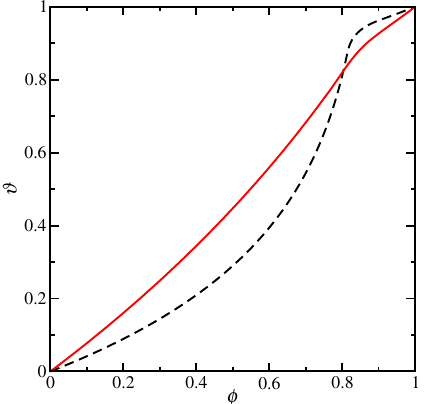
FIG. 3. ϑ ð ϕ Þ for g ¼ 0 . 8 and two different frequencies: ω ¼ 0 . 8 (dashed curve) and ω ¼ 2 (solid